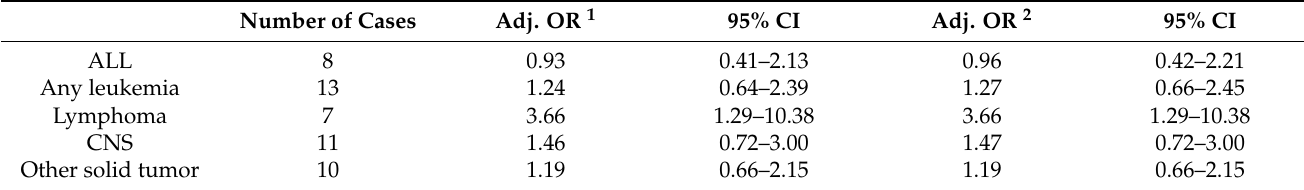
Table 3. Maternal thyroid disease and the risk for selected cancer subtypes in the offspring. Comparison to those of mothers with no thyroid